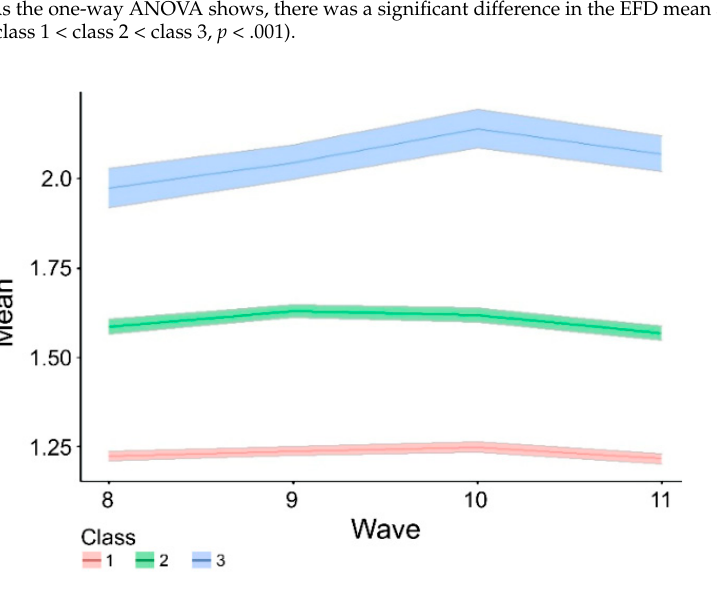
Figure 2. The mean and 95CI in EFD trajectory. For each wave 8–11 period, the mean of the EFD of the three latent layers and the confidence interval (Bootstrapping = 1000, 95% CI) by Bootstrapping are graphed. At all times, the mean of class 1 is the smallest, and the mean of class 3 is the largest. Table 3. Differences among latent layers of children’s EFD at each wave (time).